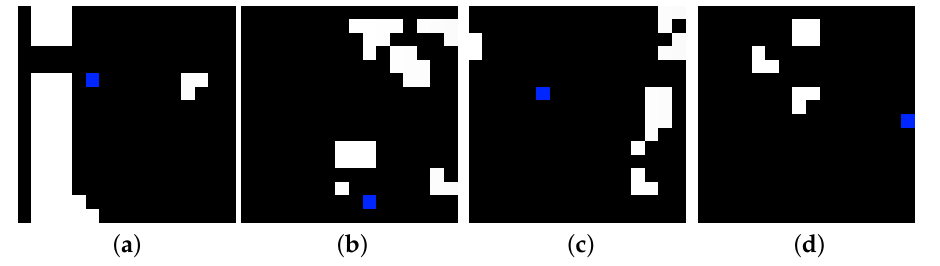
Figure 7. Examples of gridworld environments where the white color represents obstacles and the blue pixel is the agent. Each subfigure is a different environment.